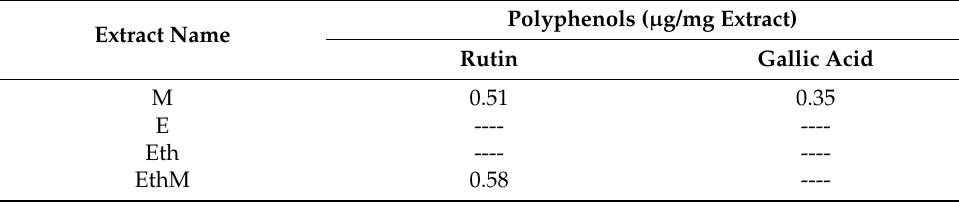
Figure 2. RP HPLC chromatograms of ( a ) standard polyphenols, ( b ) methanol, and ( c ) ethyl acetate–methanol crude extracts of C. tuberculata . Table 3. RP HPLC analysis of various solvent extracts of C. tuberculata